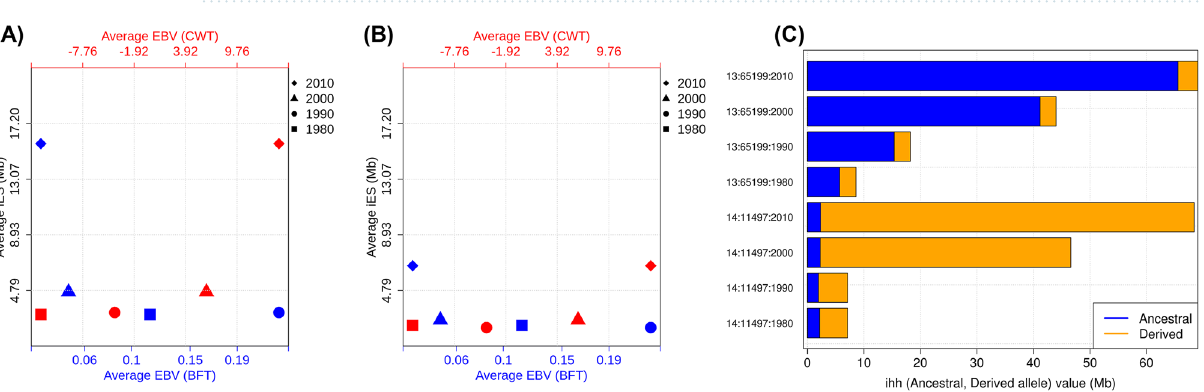
Figure 6. Haplotype increases according to EBV in 10-year increments identified in ( A ) ancestral and ( B ) derived alleles in KPN Hanwoo cattle selected for 0 years. ( C ) Decadal changes in the ratio of ancestral and derived haplotypes at ancestral and derived allele loci. In ( A ) and ( B ), the upper x-axis (red symbols) shows haplotype changes for CWT, and the lower x-axis (blue symbols) shows haplotype changes for BFT. An increase in haplotype ( C ) occurred in both alleles, and the ratios of ancestral and derived alleles